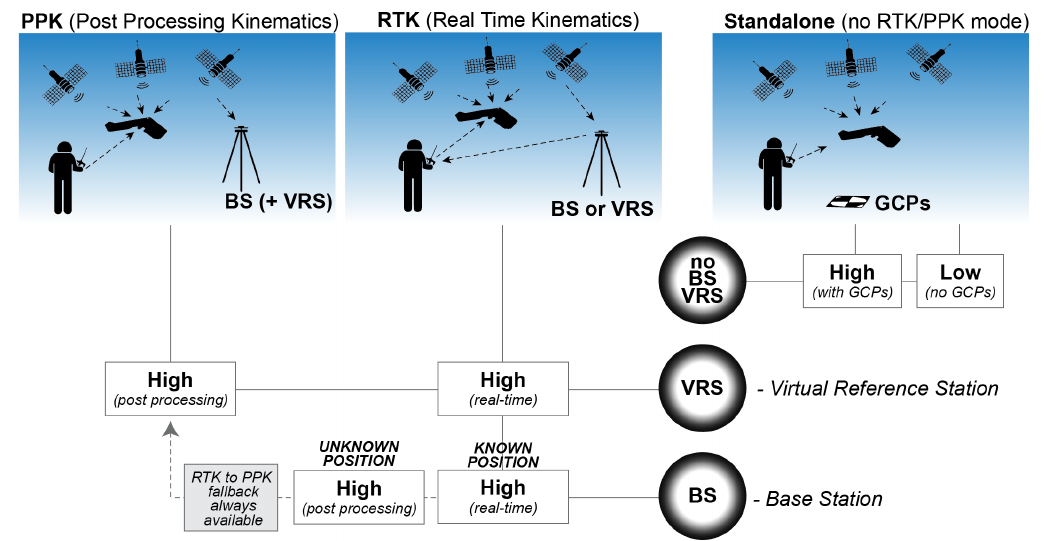
Figure 13. Achievable absolute accuracy using Real Time Kinematics or Post Processing Kinematics-enabled and Standalone